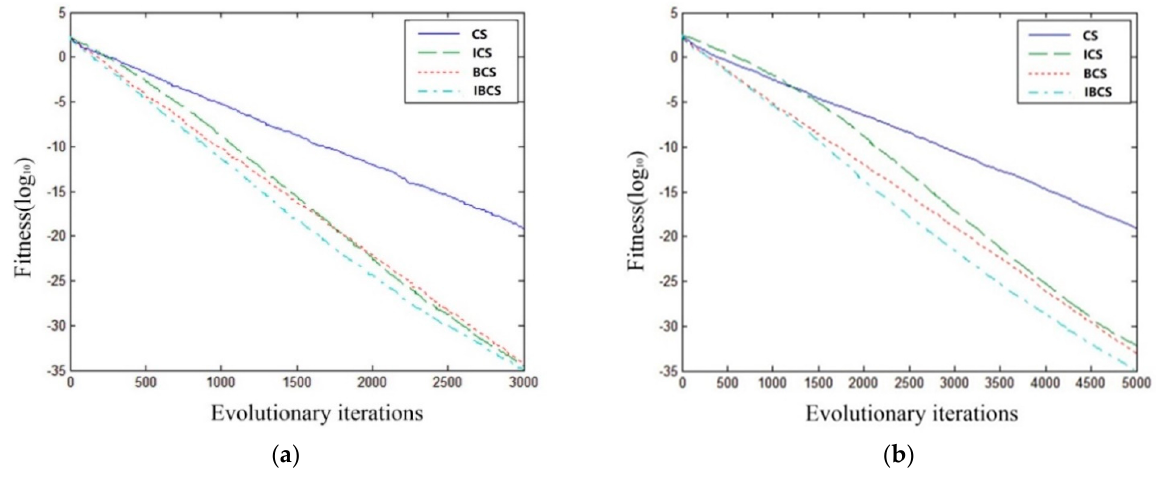
Figure 6. Comparison of the convergence results of the Shpere function; ( a ) 30 − dimensional; ( b ) 50 − dimensional.